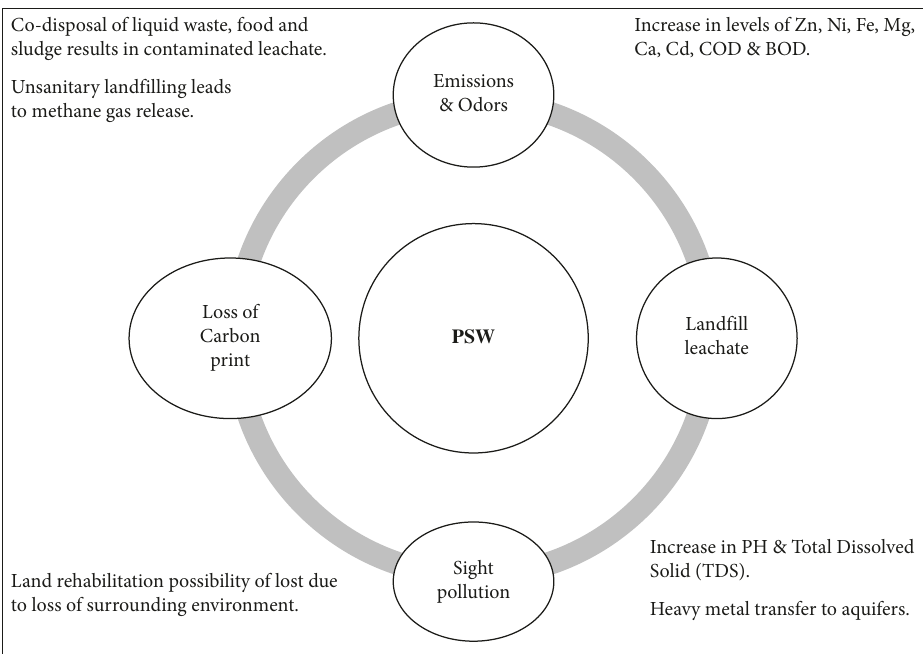
Figure 1: Associated environmental burdens of unsanitary land fi lling and/or mismanaged